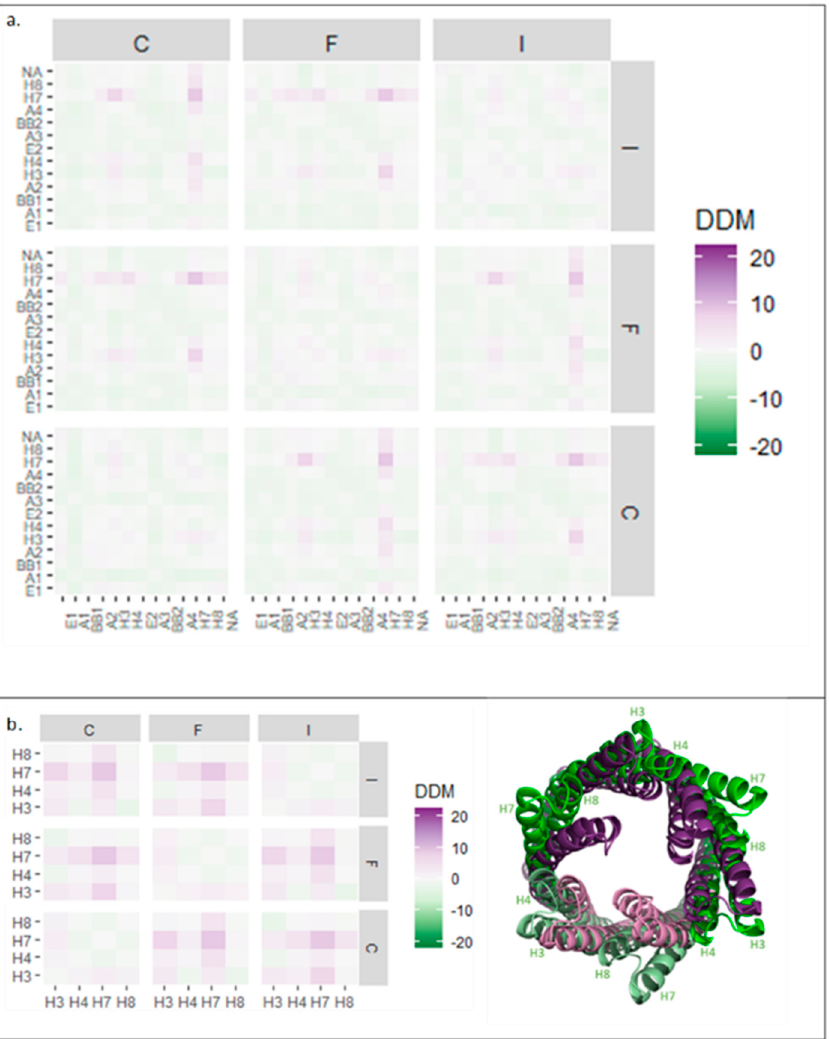
Figure 4. Block difference distance matrix (DDM) analysis of TolC domains in trimeric assembly. ( a ) Average DDM changes for all TolC domains in all three TolC protomers. ( b ) Left: Average DDM changes for TolC periplasmic helices H3, H4, H7, and H8 for all three TolC protomers. Right: TolC helices aligned in resting (purple, 5V5S) and transport (green, 5NG5) states, as viewed from above. Subunit numbering from PDB: 5NG5.